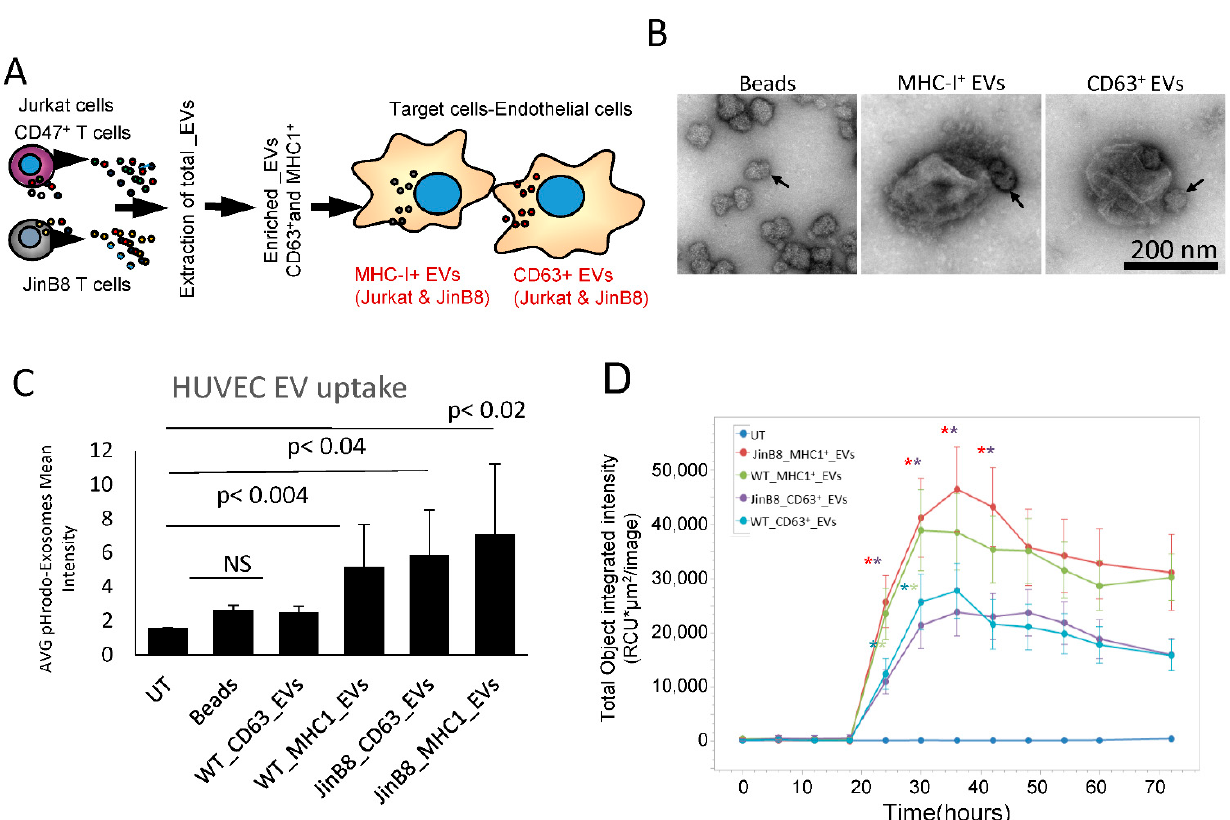
Figure 3. ( A ) Protocol for assessing HUVEC responses to MHC-I + and CD63 + EVs from WT Jurkat vs. JinB8 cells. The respective EVs were pulled down using streptavidin magnetic nanobeads bearing CD63-biotin or MHC-I-biotin antibodies. ( B ) The nanobeads alone and captured EVs were visualized by negative stain EM. Arrows indicate nanobeads. ( C ) EVs labeled with pHrodo dye were captured, washed, and incubated with HUVEC for 24 h. HUVEC uptake was quantified using cell image Cytometry Celigo. ( D ) Kinetics of EV uptake by HUVEC were measured using Incucyte Live cell imaging analysis ( n = 6 replicates per experiment, and two biological experiments). Significance was assessed using Student’s t test. For WT Jurkat CD63 + vs. WT Jurkat MHC-I + EVs. Asterisk colors indicate significance of the corresponding line graphs (*) with p values significant at 24 h (0.03) and 30 h (0.04), and for JinB8 CD63 + vs. JinB8 MHC-I + EVs from 24–42 h (0.0006, 0.002, 0.001, 0.002) respectively. No significant p values were observed between WT Jurkat MHC-I + vs. JinB8 MHC-I + EVs or WT Jurkat CD63 + versus JinB8 CD63 +